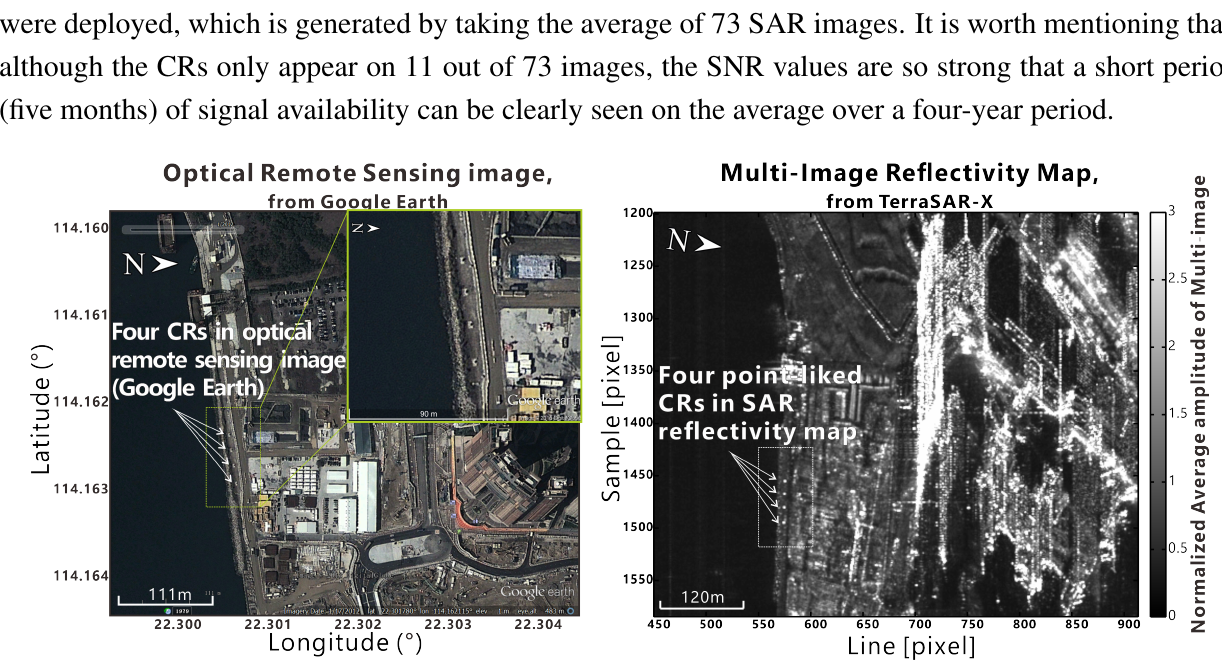
Figure 4. Left : the location of CRs geocoded to the optical image. The location is near the sea that is identical for its low intensity in radar images. Right : the location and intensity of the four CRs on TSX images. From the image, we can see that the backscatter in that area is very low, and the intensity of the CRs is considerably